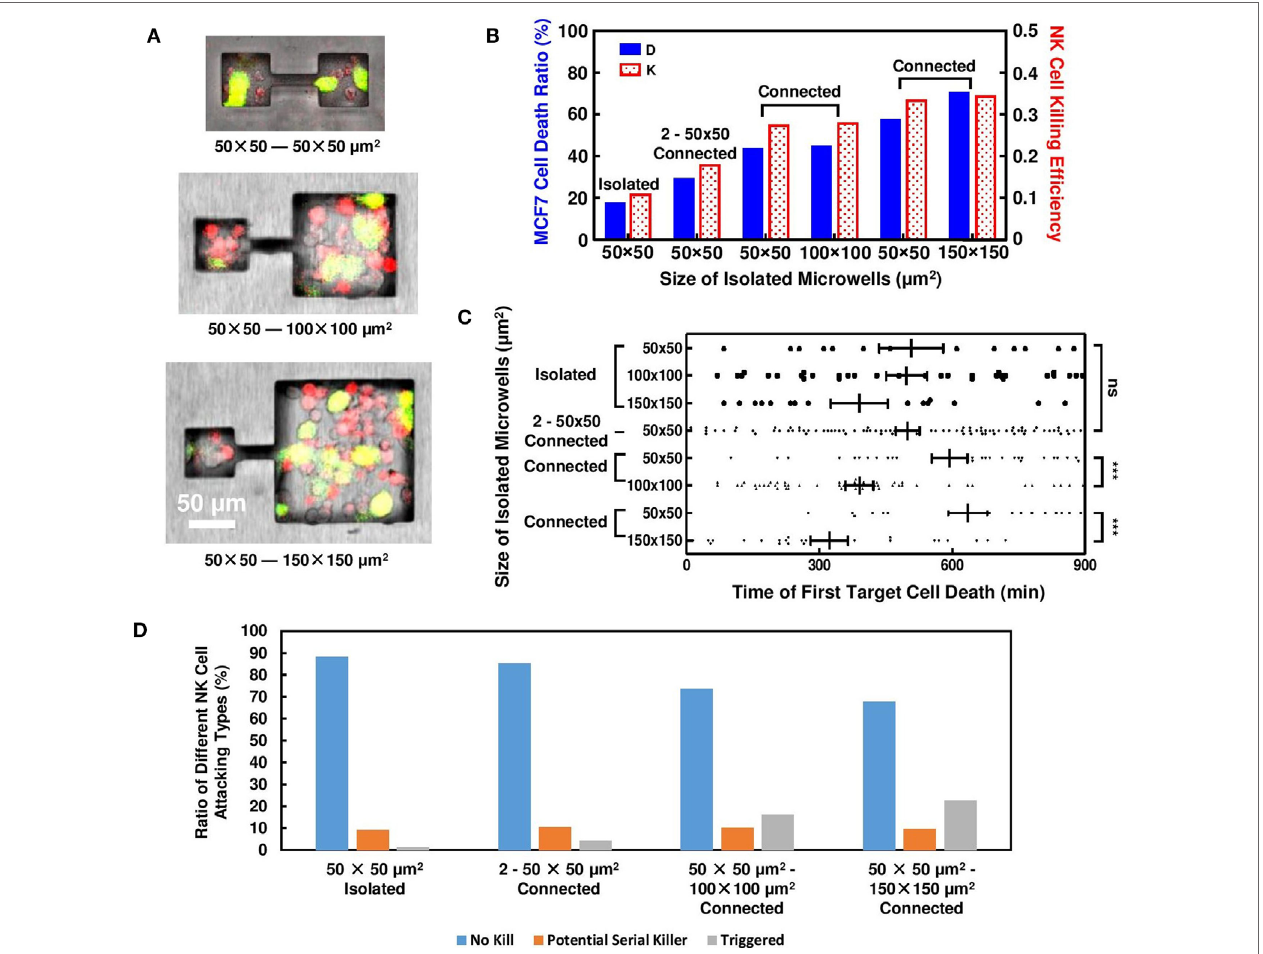
FigUre 4 | Natural killer (NK) cell cytotoxicity in connected microwells. Results obtained from isolated microwells are listed for comparison. (a) MCF7 and NK cells distributions in microwells connected by 50-µm long, 10-µm wide microchannels. (B) Connection between 50 μ m × 50 μ m microwells with microwells of larger sizes increased NK cell cytotoxicity. (c) Time for first MCF7 cell death in connected microwells; in 2–50 μ m × 50 μ m microwells, triggering time was similar to isolated wells; when connected to larger microwells, triggering time of first target cell death in 50 μ m × 50 μ m microwells was delayed. (D) Proportion of NK cell in different attacking modes for isolated and connected microwells. More NK cells in triggered mode were observed when 50 μ m × 50 μ m microwells were connected to 100 μ m × 100 μ m and 150 μ m × 150 μ m